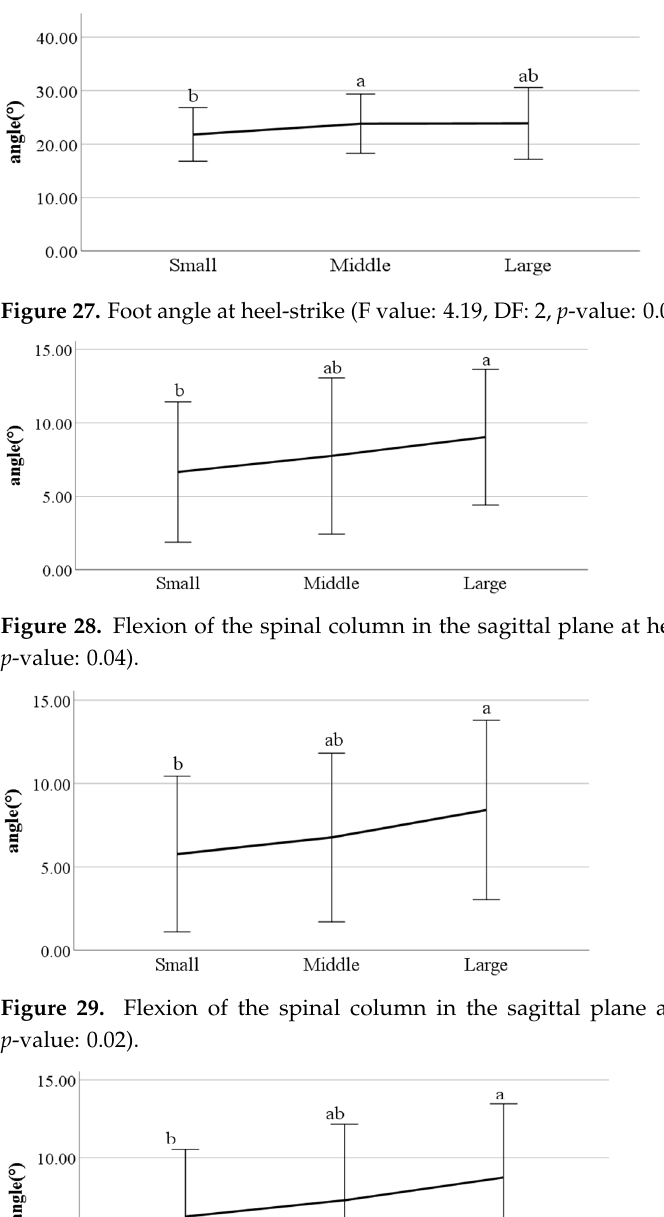
Figure 26. The ratio of stance phase of right foot (F value: 3.12, DF: 2, p -value: 0.04).